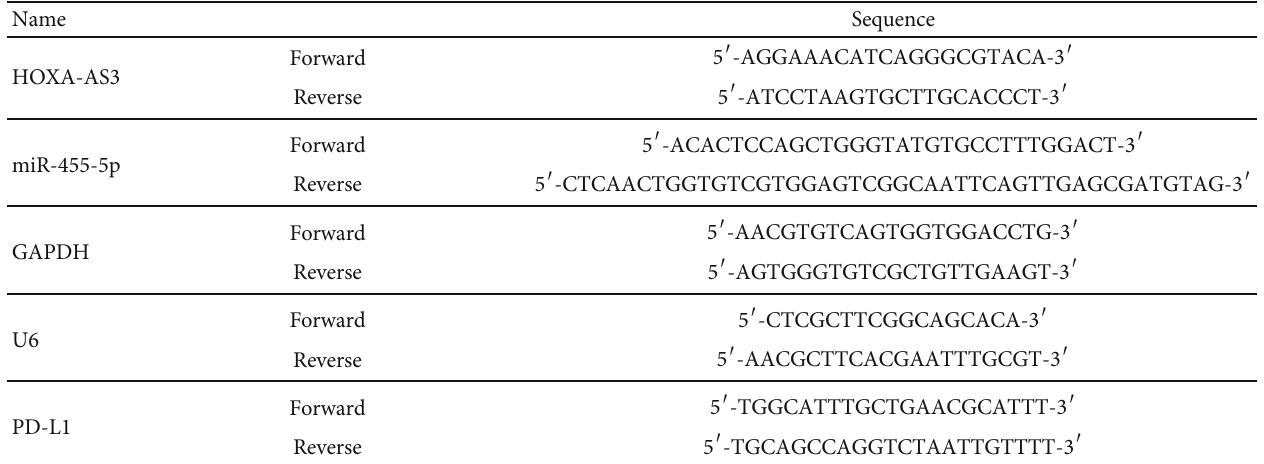
Table 1: Sequences of primers for